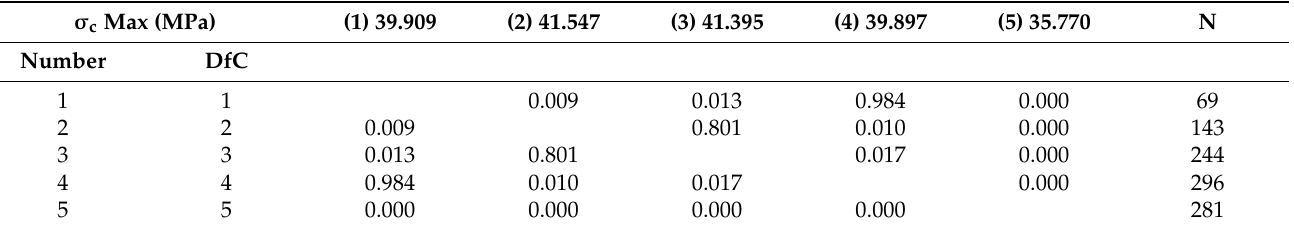
Table 7. Statistical evaluation of the effect of distance from center (DfC) on compressive strength using Duncan ´ s